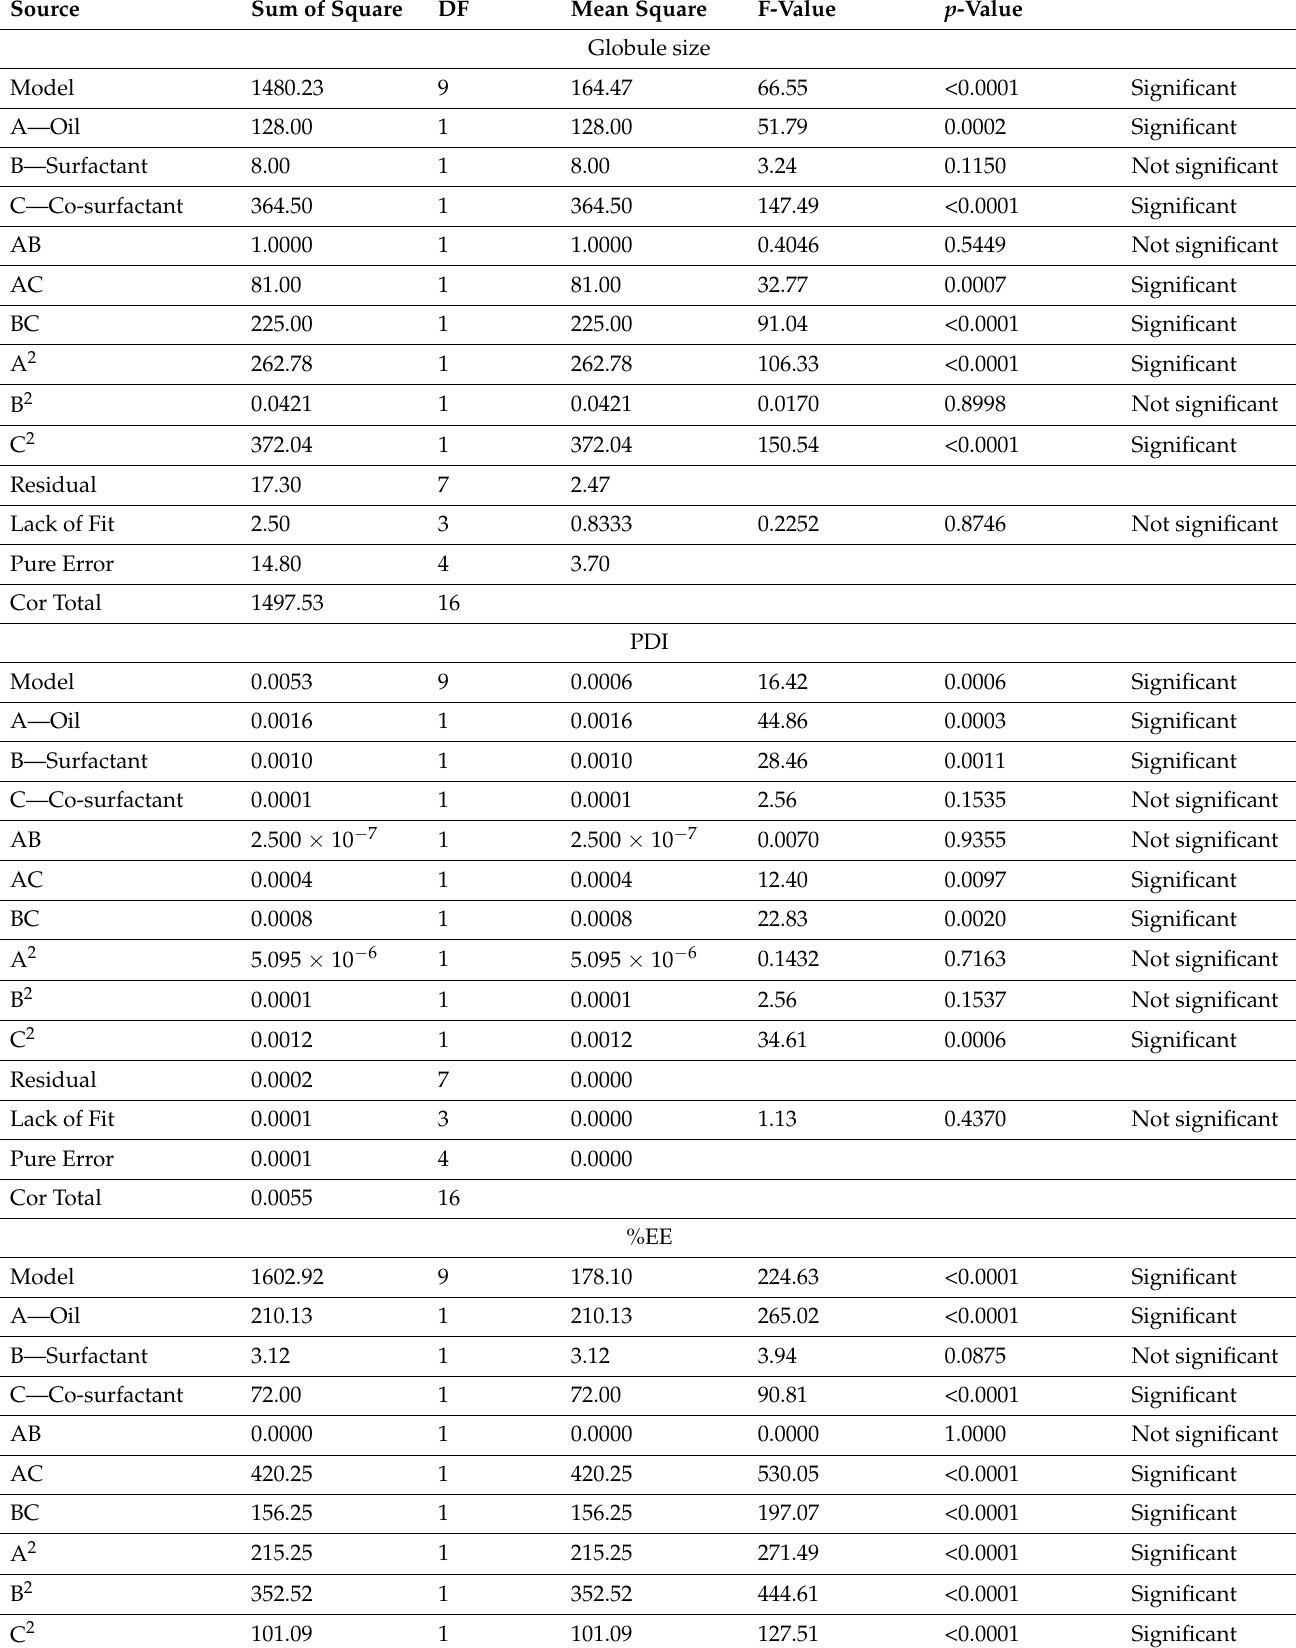
Table 2. ANOVA results for responses: globule size, PDI and